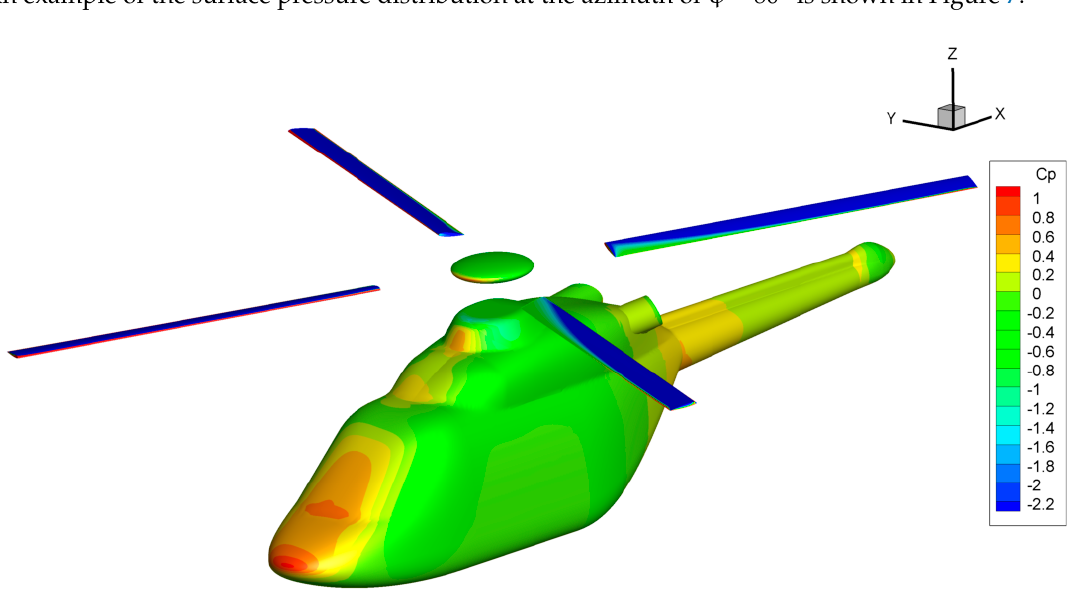
Figure 7. Surface pressure coefficient on the fuselage and blades at the conditions of Table 1.